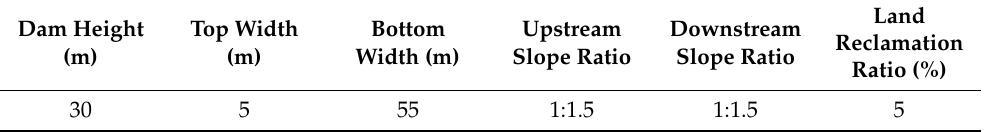
Table 2. Design-foundation parameters of check dam.